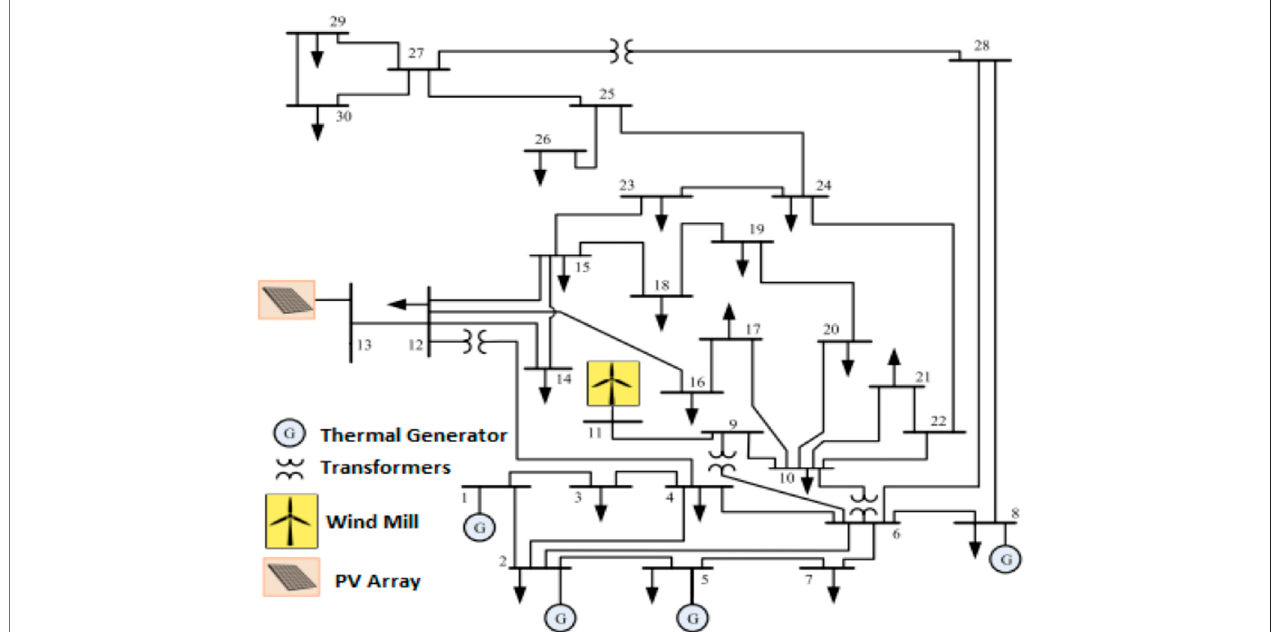
FIGURE 2 | Architecture of the NN.